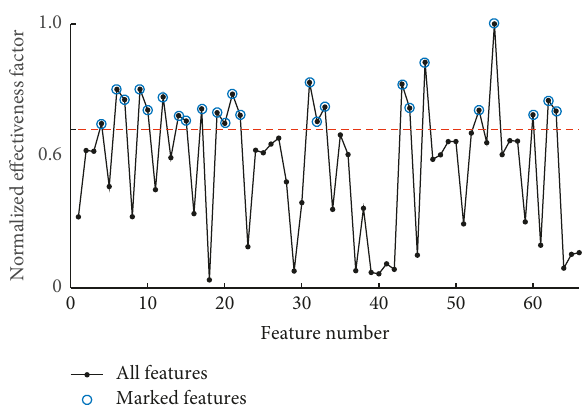
Figure 18: The marked features of IMFs components derived from BMD decomposition.